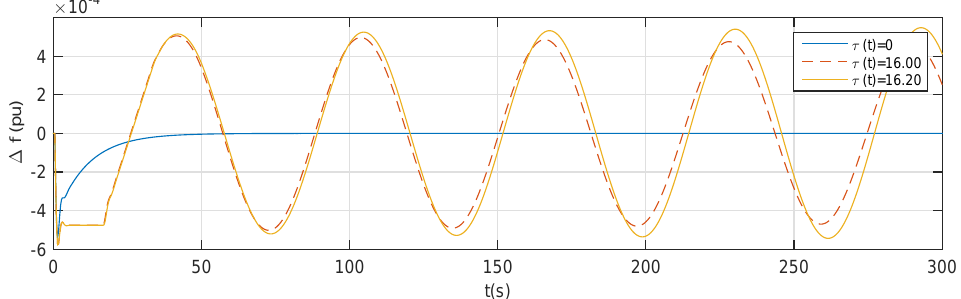
Figure 3. Frequency deviation of one-area LFC model with constant delay.